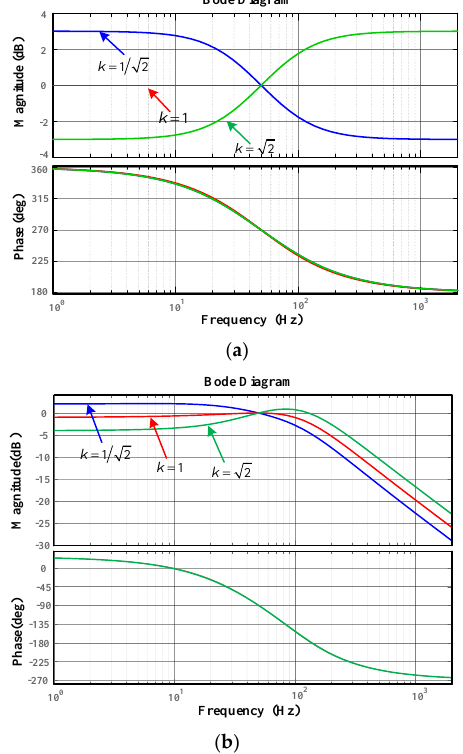
Figure 7. Bode plot of MFOF before and after improving: ( a ) bode plot of ( ) Q s ; ( b ) bode plot of ( ) Q s 